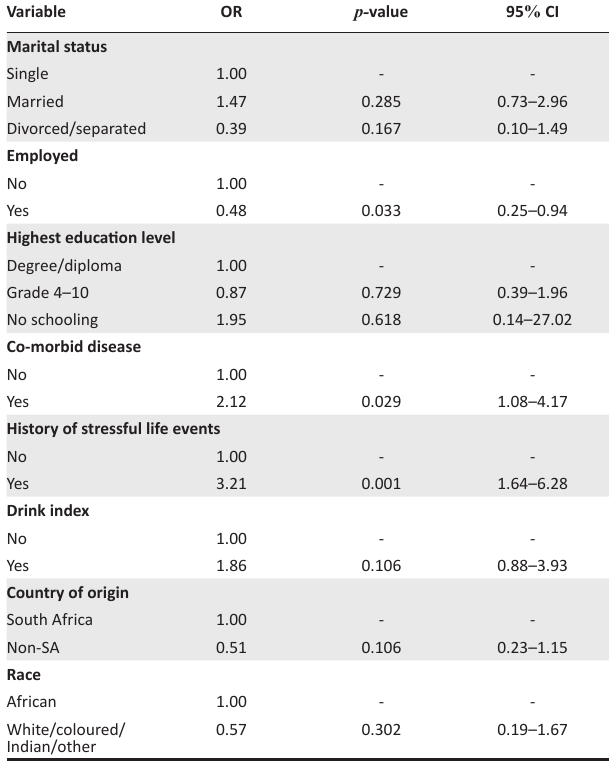
TABLE 4: Multivariate logistic regression model for factors associated with screening positive on the patient health questionnaire-9.